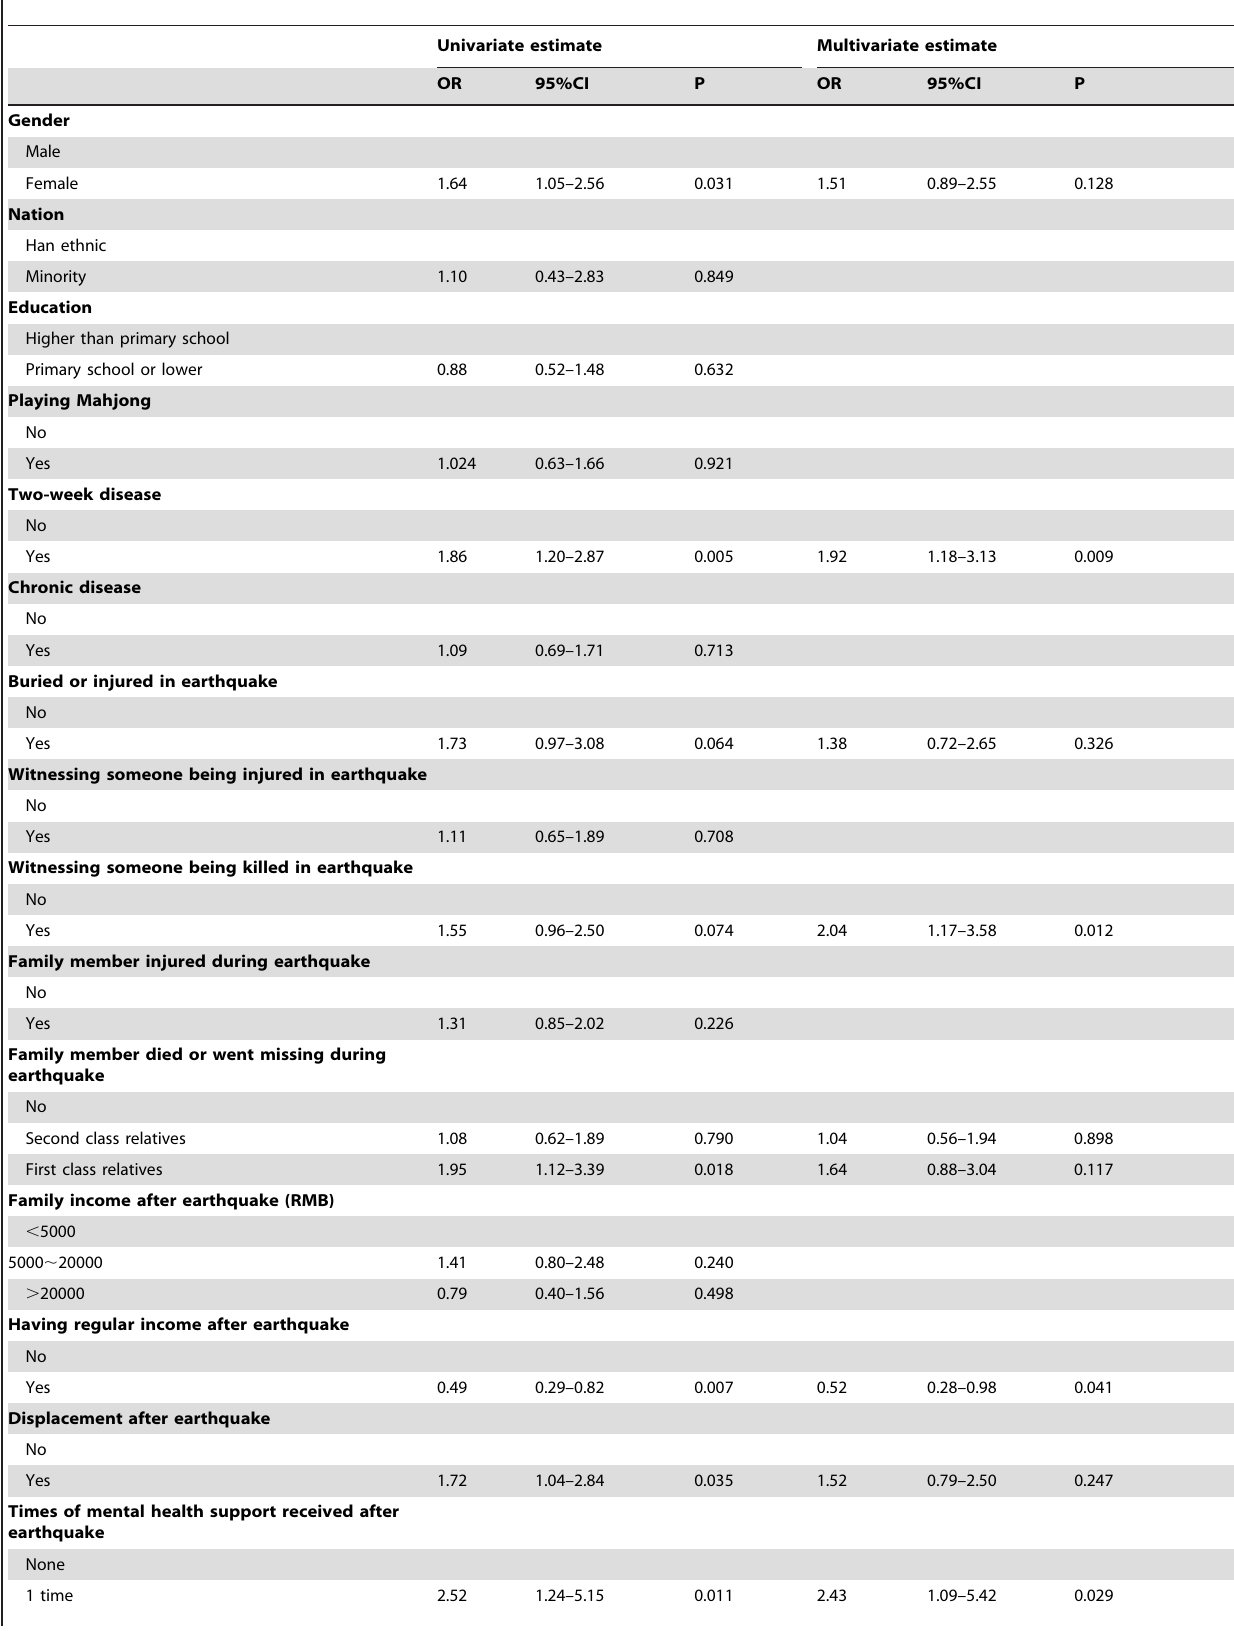
Table 2. Results of conditional logistic